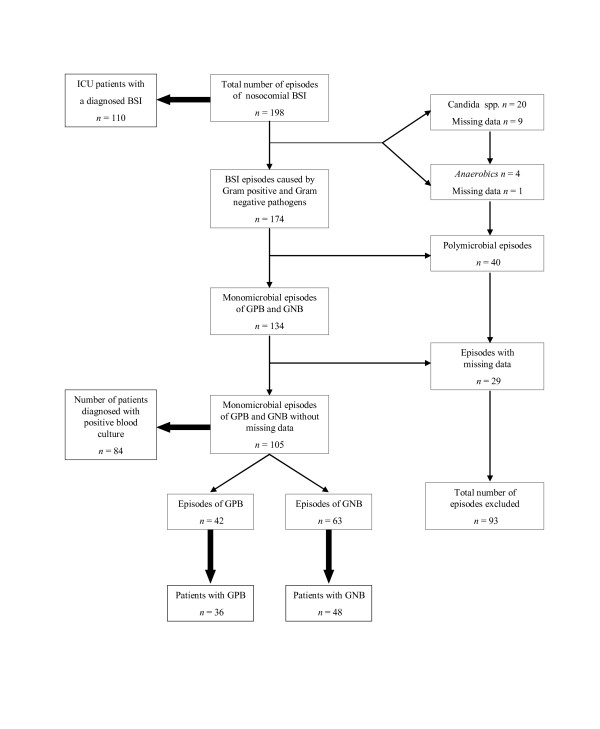
Flow chart of exclusion criteria of episodes of nosocomial bacteremia (2003–2004). ICU, intensive care unit; BSI, bloodstream infection; GPB, Gram positive bacteremia; GNB, Gram negative bacteremia.